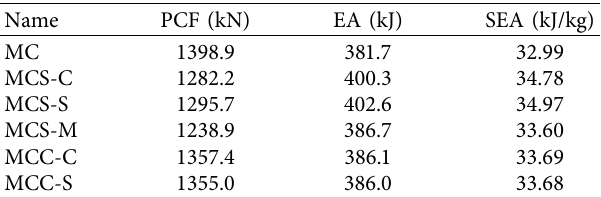
Figure 7: Relationship between f , EA, and force-displacement curve. Table 2: Crashworthiness index of the different multi-cell